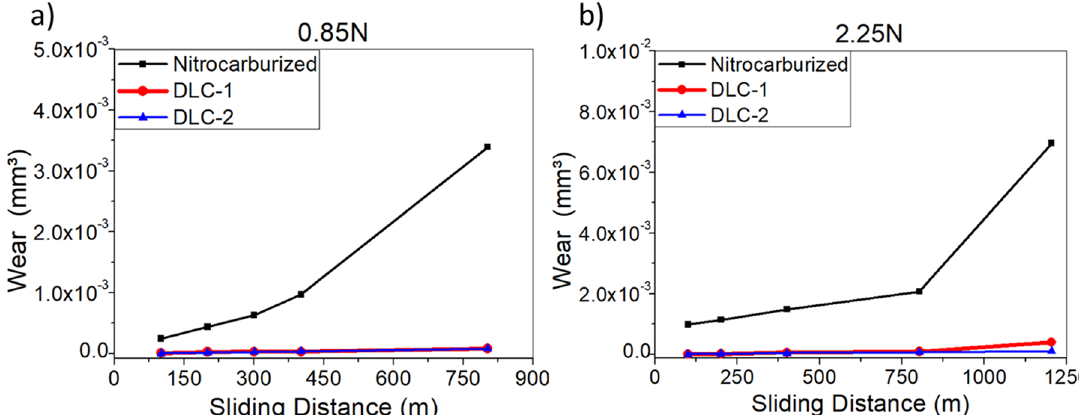
Figure 5. Sliding sphere wear test in the nitrocarburized condition and after DLC deposition, a) load of 0.85N and b) 2.25N.